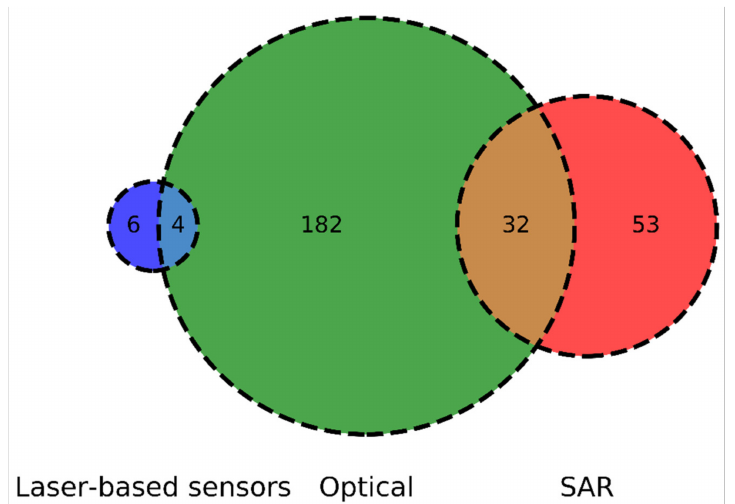
Figure 9. Sensors utilized in screened